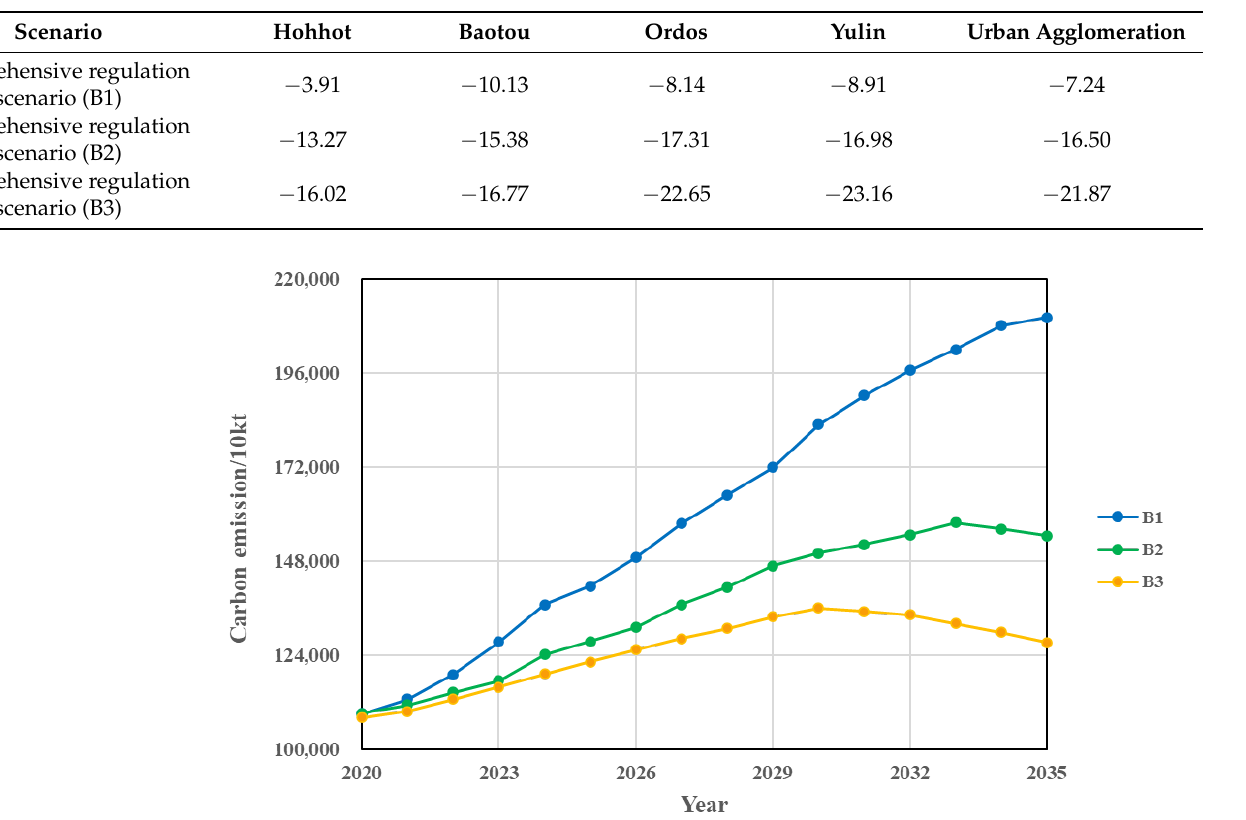
Figure 8. Carbon emission projections for urban agglomeration under different comprehensive regulation scenarios.